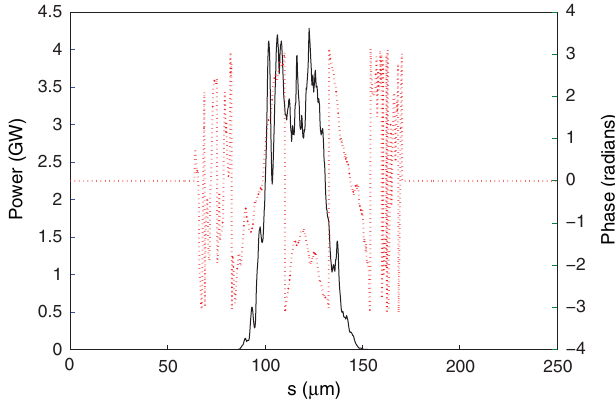
FIG. 10. (Color) Start-to-end, HGHG: single shot radiation power (black solid line) and phase (red dashed line) along the beam at saturation in the radiator ( z ¼ 11 m ).